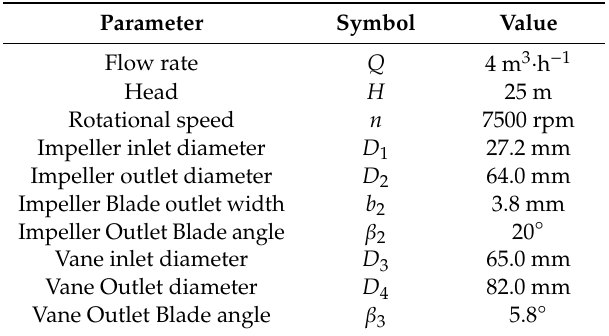
Table 1. Main parameters of high - speed centrifugal pump.